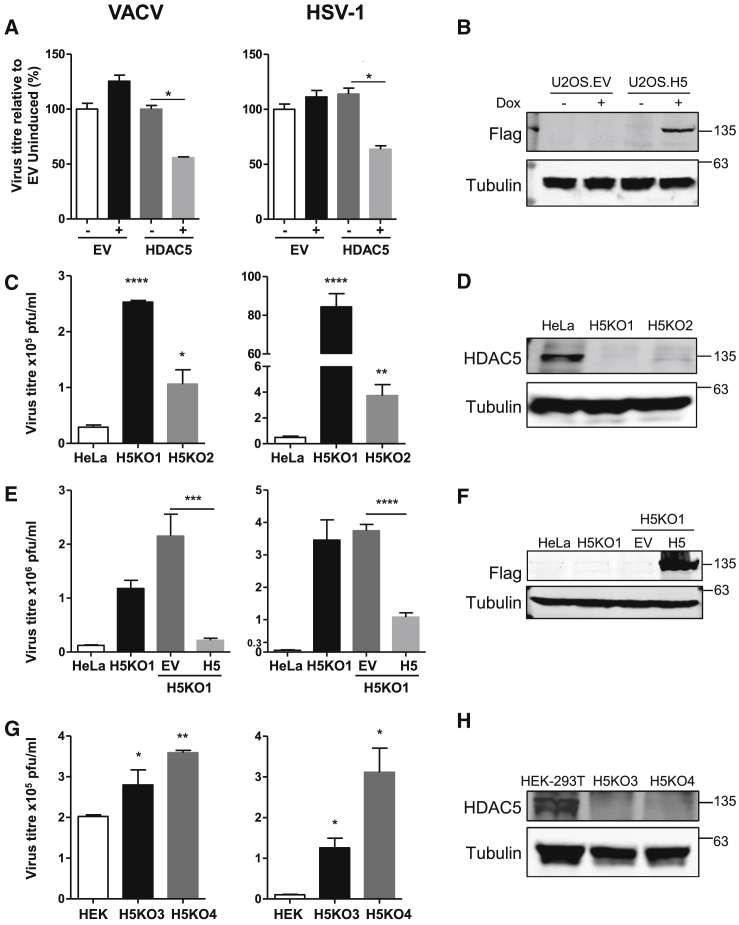
HDAC5 Restricts VACV and HSV-1 Infection(A) Diminished replication of VACV and HSV-1 in an U2OS cell line inducibly expressing HDAC5-FLAG. Infections were performed at MOI = 0.001, for 2 days with VACV and 3 days with HSV-1, after induction with 100 ng/ml doxycycline overnight. Data are represented as mean ± SEM, p values were calculated using a two-tailed t test (n = 3). ∗p < 0.05 and ∗∗p < 0.01; ns: not significant.(B) Immunoblot of HDAC5-FLAG expression in U2OS cell lines.(C) Enhanced replication of VACV and HSV-1 in HeLa CRISPR/Cas9 HDAC5−/− knockout clones compared to parental cell lines. Infections were performed as detailed in (A). Data are represented as mean ± SEM, p values were calculated using a two-tailed t test (n = 3). ∗p < 0.05, ∗∗p < 0.01, and ∗∗∗p < 0.001.(D) Immunoblot confirmed knockout of HDAC5. Sequencing of genomic DNA from clones H5KO1 and H5KO2 confirmed frameshift mutations in both alleles (Table S7A).(E) Reintroduction of HDAC5 in HDAC5−/− cells restored restriction of VACV and HSV-1 replication. H5KO1 cells were transduced with either empty vector (EV) or HDAC5-FLAG. Infections were performed as detailed in (A). Data are represented as mean ± SEM, p values were calculated using a two-tailed t test (n = 3). ∗∗∗p < 0.001 and ∗∗∗∗p < 0.0001.(F) Immunoblot analysis of HDAC5-FLAG expression in H5KO1 cell lines.(G) Enhanced replication of VACV and HSV-1 in HEK293T CRISPR/Cas9 HDAC5−/− knockout clones compared to parental cell lines. Infections were performed as detailed in (A). Data are represented as mean ± SEM, p values were calculated using a two-tailed t test (n = 3). ∗p < 0.05 and ∗∗p < 0.01.(H) Immunoblot confirming knockout of HDAC5. Sequencing of genomic DNA from clones H5KO3 and H5KO4 confirmed frameshift mutations in both alleles (Table S7A).